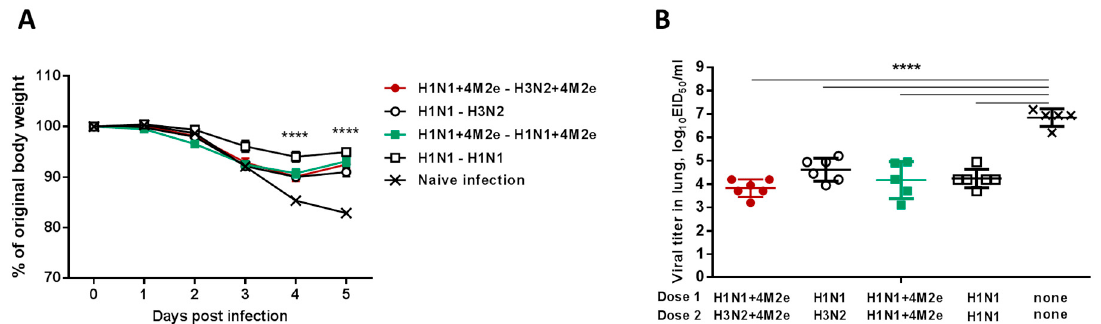
Figure 6. Protection against challenge with H5N1 virus of different LAIV immunization protocols. ( A ) Dynamics of body weight change. ( B ) Infectious viral titers in mouse lungs three days after challenge with rgH5N1 virus. Data were compared with two-way ( A ) or one-way ( B ) ANOVA followed by Tukey’s multiple comparisons test (**** p < 0.0001).